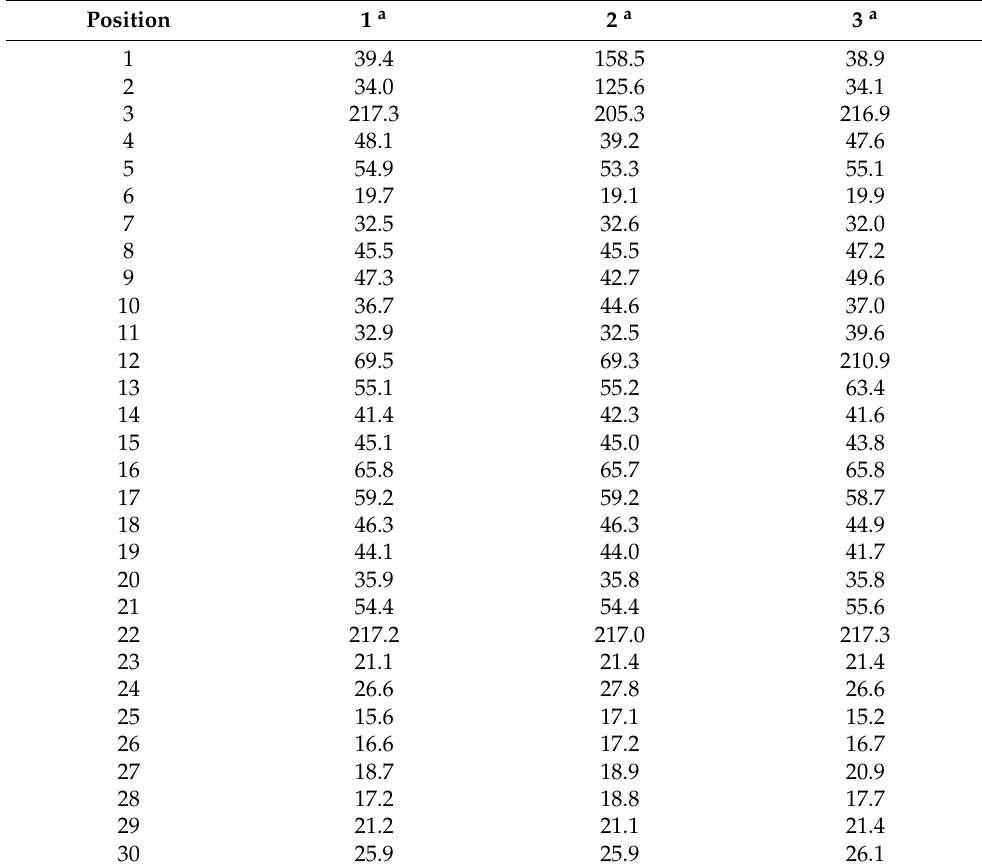
Table 2. 13 C-NMR data for Compounds 1 – 3 ( δ in